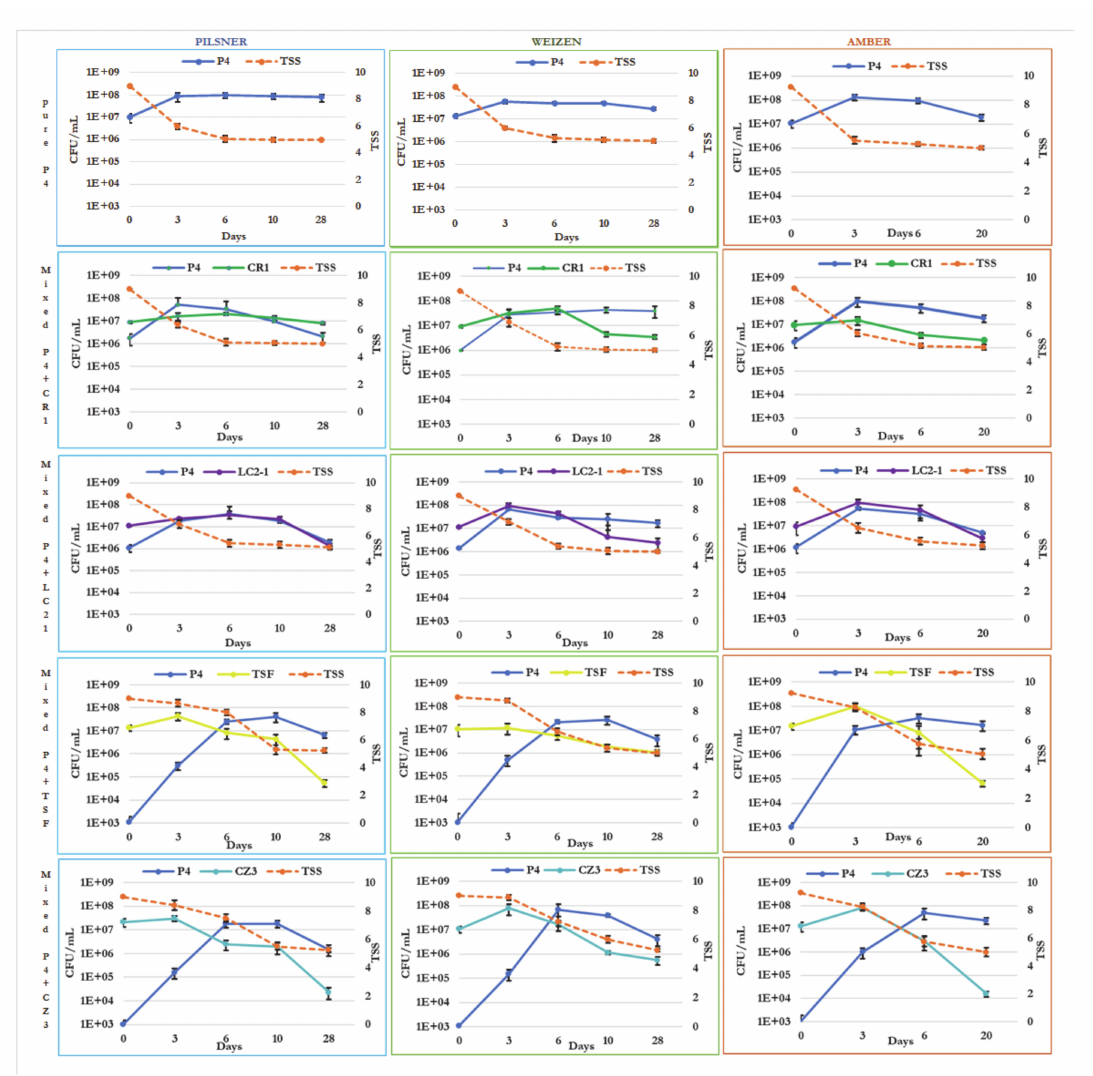
Figure 2. Fermentation kinetics of single and mixed starter cultures composed of S. cerevisiae (P4) and non- Saccharomyces strains ( Z. bailii CR1, T. delbrueckii LC2-1, C. zemplinina TSF and CZ3) during fermentation in three different worts (PW, WW, AW), reported as cell counts on the left y -axis and reduction of total soluble solids (TSS) on the right y -axis. Continuous lines, viable cells; dotted lines, TSS. Data are the mean values ± standard deviations of two independent